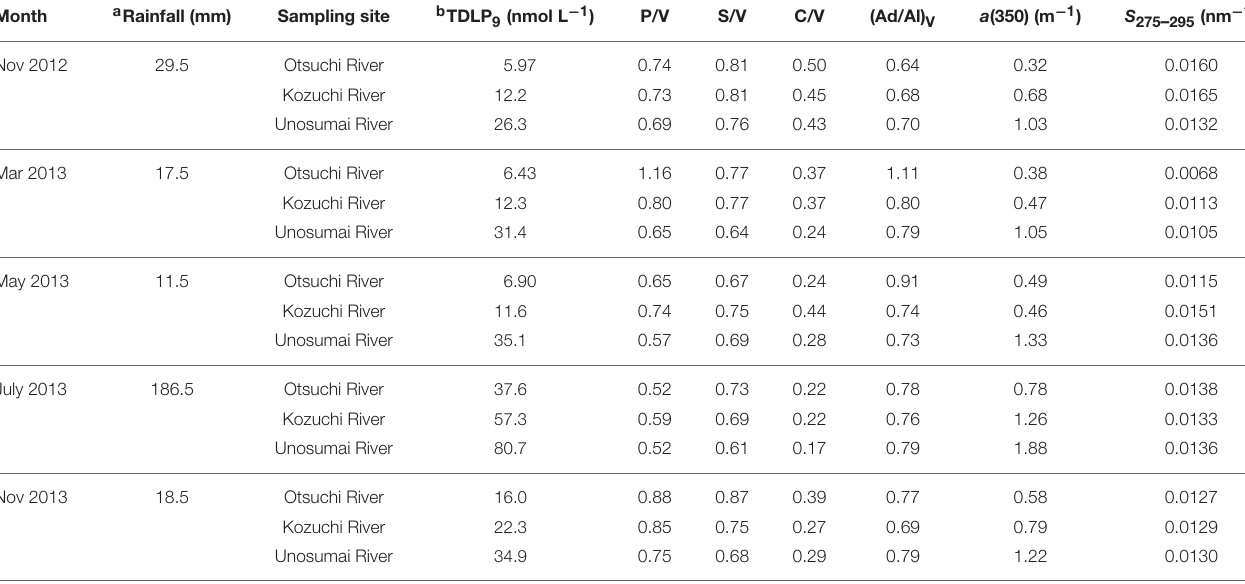
TABLE 1 | Dissolved lignin phenol concentrations (TDLP 9 ), composition ratios [P/V, S/V, C/V and (Ad/Al) V ] and CDOM absorption coefficient at 350nm [ a (350)] and spectral slope 275–295nm [ S 275 – 295 ] in the rivers.